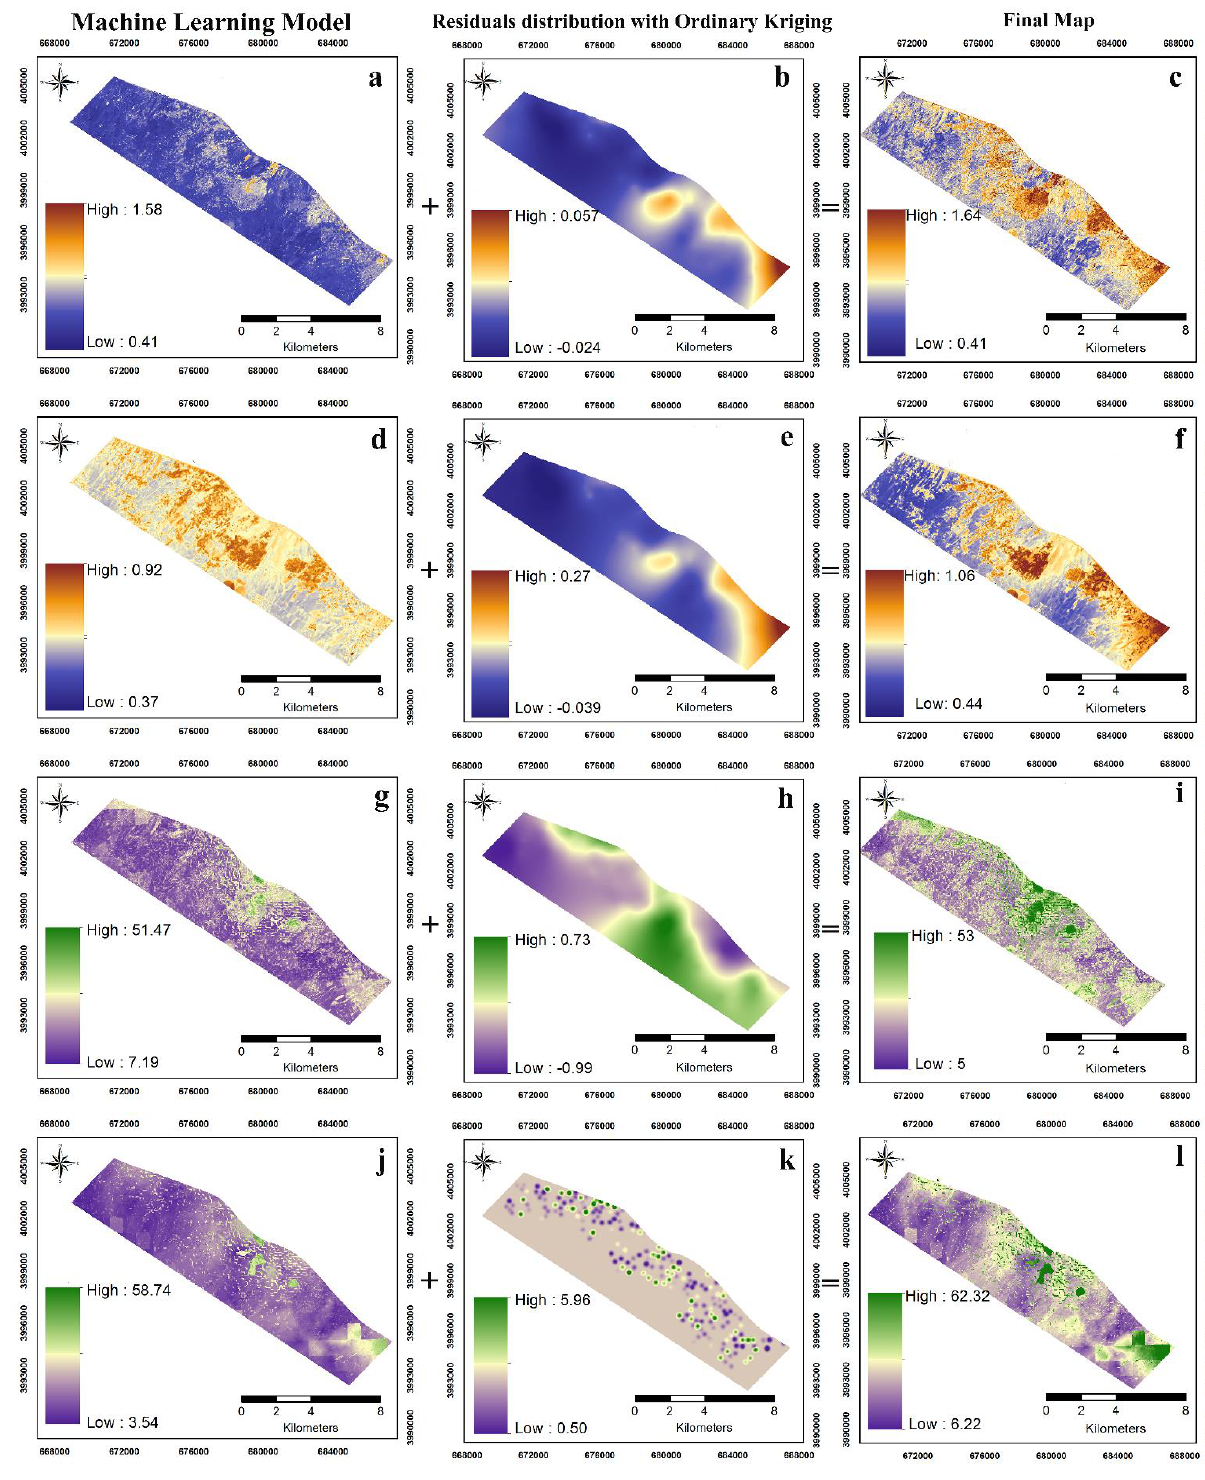
Figure 6. Map of predicted soil organic carbon and soil available phosphorus (First column: ( a ) RF-SOC, ( d ) Cubist-SOC, ( g ) RF-Ava-P, ( j ) Cubist-Ava-P, purely machine learning used in produced maps; second column: ( b ) RF-SOC residuals, ( e ) Cubist-SOC, ( h ) RF-Ava-P residuals, ( k ) Cubist-Ava-P residuals, model residual maps produced using ordinary kriging; third column: ( c ) RFRK-SOC, ( f ) CubistRK-SOC, ( i ) RFRK-Ava-P, ( l ) CubistRK-Ava-P, Final maps). Abbreviations: RF: Random forest, SOC: Soil organic carbon, Ava-P: Available phosphorus, RFRK: random forest combined with kriging, CubistRK: Cubist combined with kriging.